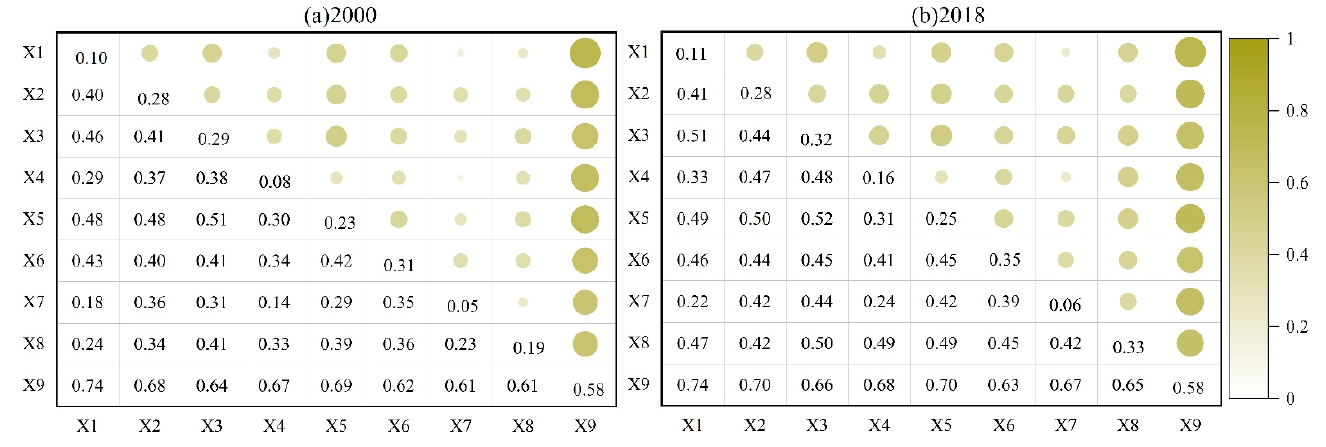
factors. Thus, the interactive effect between natural and socioeconomic factors further en- hanced the effect on the spatial differentiation of ESV. Specifically, in the northeast, north- west, and southwest regions, the main interactions came from the interaction between natural factors and distance from road (X9) in 2000 and 2018. The interaction between elevation (X2) and distance from road (X9) in the northeast region was always the largest; Table 5. Q statistic of the driving factors of ESV in different regions in 2000 and 2018. The interaction between distance from road (X9) and altitude (X2) and the interaction be- tween distance from road (X9) and annual average temperature (X3) in Northwest China X1 always ranked in the top two. In the southwest region, the interactions between distance from road (X9) and natural factors were above 0.90, and the interaction intensity was rel- atively large. The primary interactions in north China, east China, and the south central region were produced by the interaction of natural factors and the intensity of develop- ment land (X8). During the research period, the top three interactions in north China were primarily the interaction intensity among construction land intensity (X8), with elevation (X2), annual average temperature (X3), and NDVI (X5), all of which had interaction strengths over 0.92; In east China and the south central region, the interaction between slope (X1) and construction land intensity (X8) was the strongest, and the interaction be- tween them kept growing as the years passed.